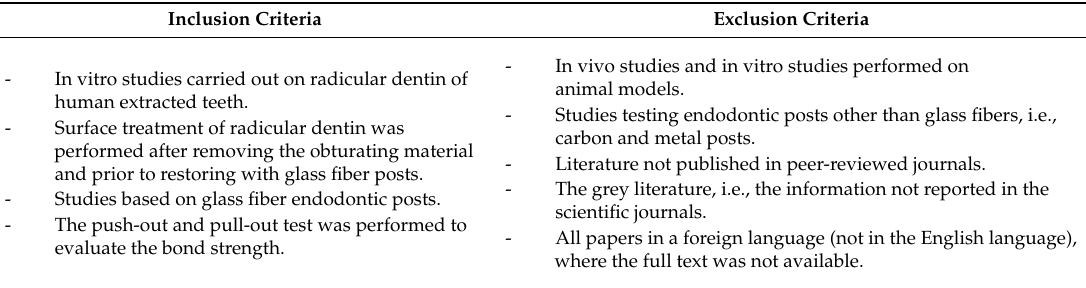
Table 1. The inclusion and exclusion criteria for